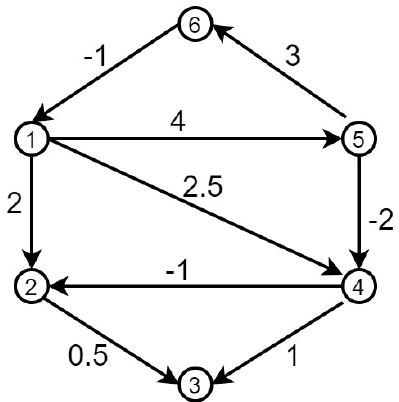
Figure 2. Topology graph among six agents.